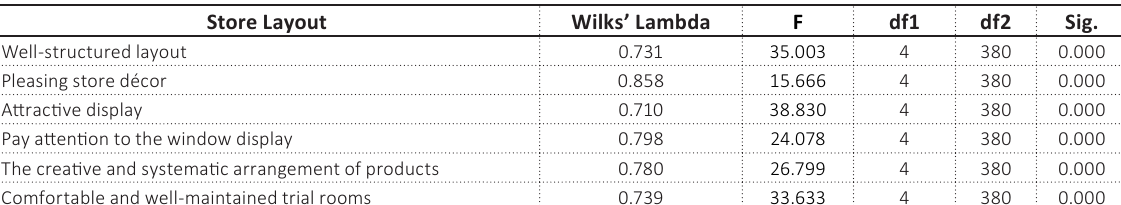
Table 2. Discriminant validity of store